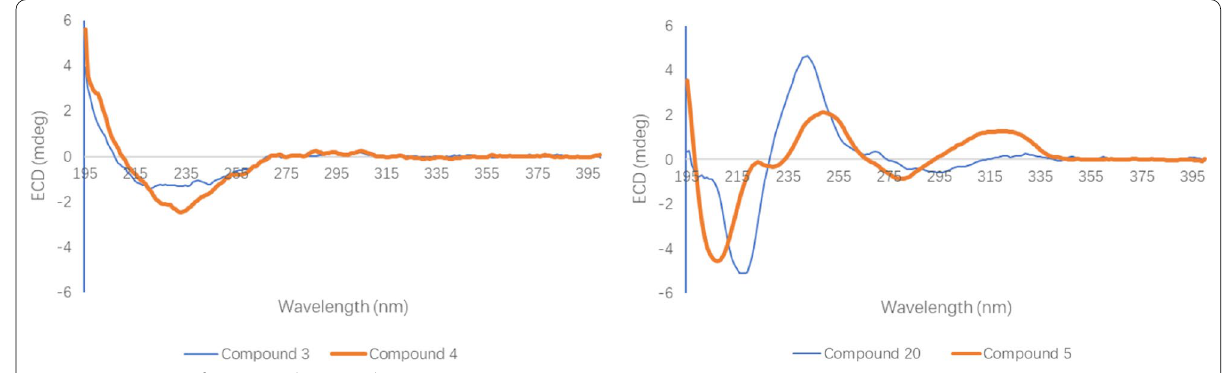
Fig. 4 ECD spectra of compounds 3 – 5 and